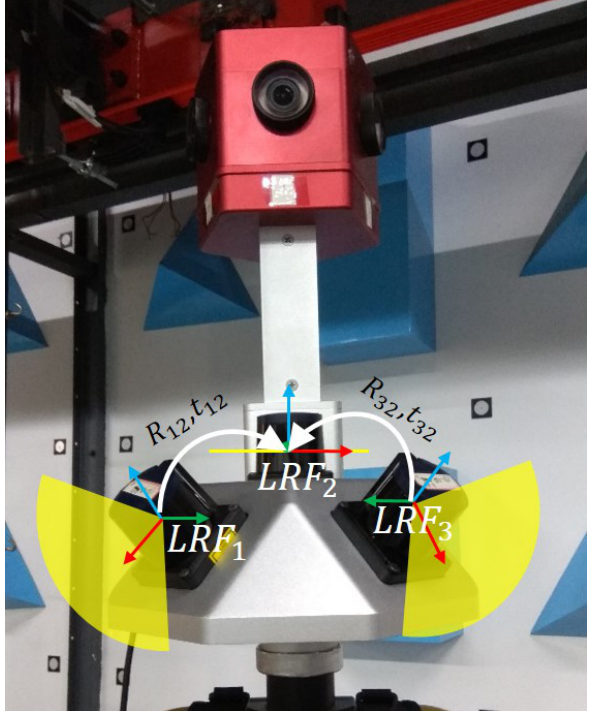
Figure 8. The SLAM device we used in the real experiment. Three LRFs on the SLAM device are denoted as LRF1, LRF2, and LRF3 from left to right, respectively. Assuming that the LRF2’s coordinate system is the reference coordinate system, the task of calibrating extrinsic parameters is to get the transformation relationships between the LRF1, LRF3 coordinate system, and the reference coordinate